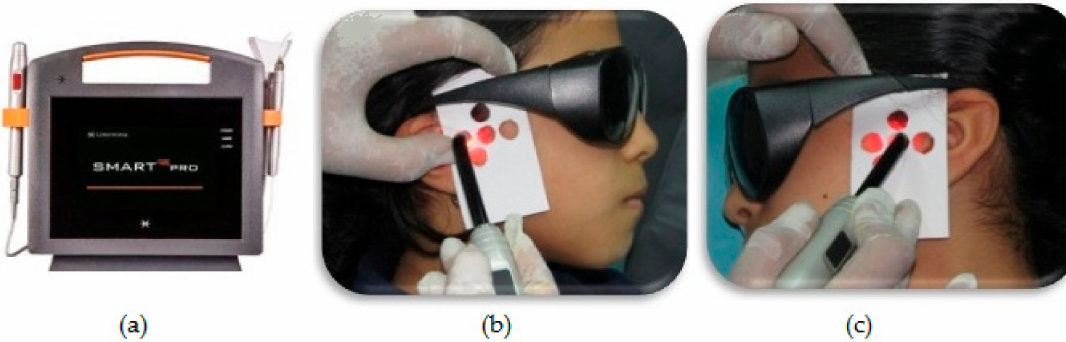
Figure 1. ( a ) Gallium–aluminum–arsenide semiconductor diode laser equipment used in study. Application of low-level laser therapy (LLLT) at five points within temporomandibular joint (TMJ) area on both sides for a female patient. Right side ( b ); left side ( c ).